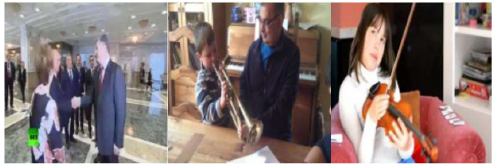
Figure 24. Samples from kinetics dataset